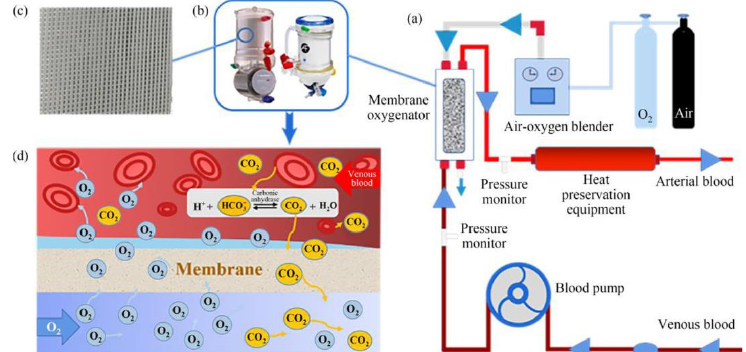
Figure 4. ( a ) ECMO system composition diagram; ( b ) Schematic diagram of common membrane oxygenators; ( c ) hollow fiber membrane filament for gas and blood exchange; ( d ) Schematic diagram of blood oxygen exchange principle. (reproduced with permission after [26] ).